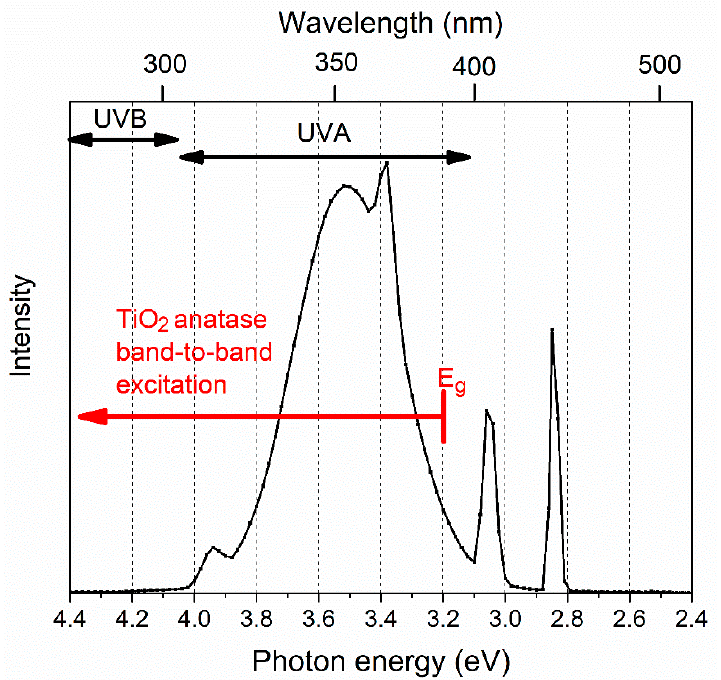
Figure 7. Emission spectrum of the used UVA light bulb 15 W iSOLde Cleo. Band gap (Eg) of the TiO 2 anatase crystal phase, UVA, and UVB spectral regions are also marked on the figure.